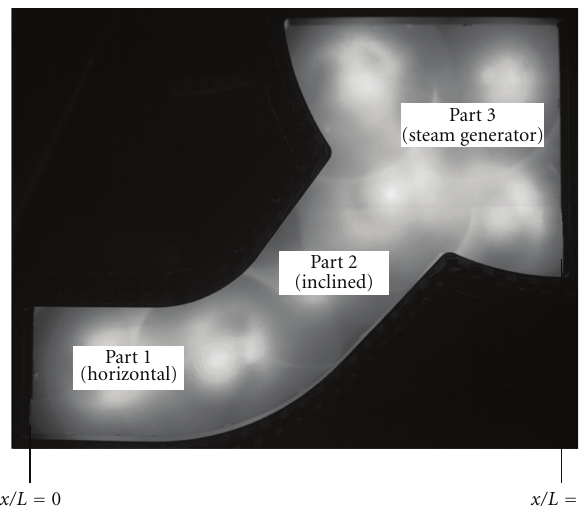
Figure 4: Submatrix segmentations in the image processing.